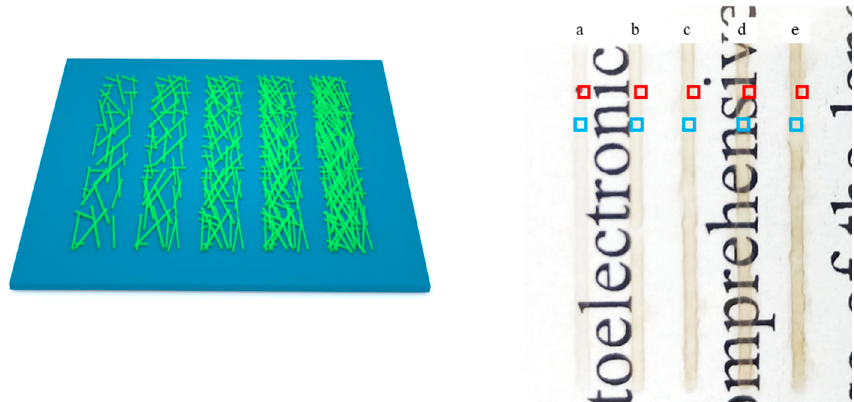
Figure 8. Designed patterns with length of 20 mm and width of 500 µm and different printed layers ( left ), photographs of printed patterns ( right ) with 5 (curve a), 10 (curve b), 15 (curve c), 20 (curve d) and 25 layers (curve e) after heat treatment.